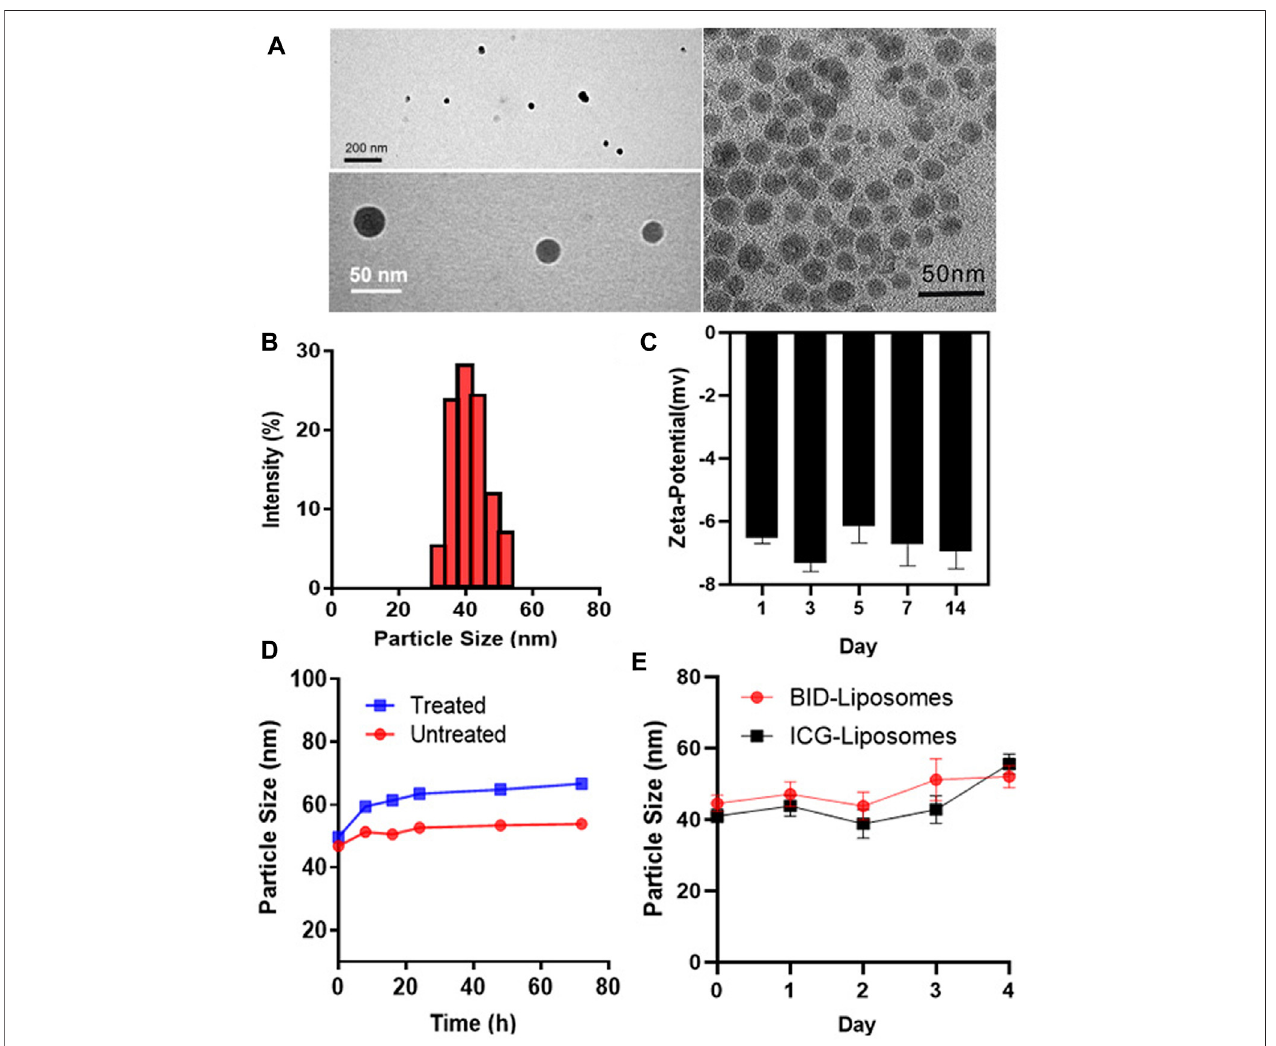
FIGURE 3 | In vitro characterization of BID-liposomal nanocomposites. (A) TEM images of BID-liposomal nanocomposites and the inorganic components of the core. Scale bar: 200 and 50 nm. (B) Particle size assay of BID liposomal nanocomposites. (C) Changes in zeta potential of BID-liposomal nanocomposites over the incubation time. (D) Changes in the particle size of BID-liposomal nanocomposites treated or untreated with a medium containing 10% serum at 37 ° C within 3 days (E) Storage stablity of BID-liposomal nanocomposites and ICG-Liposomal nanocomposites at 4 ° C.